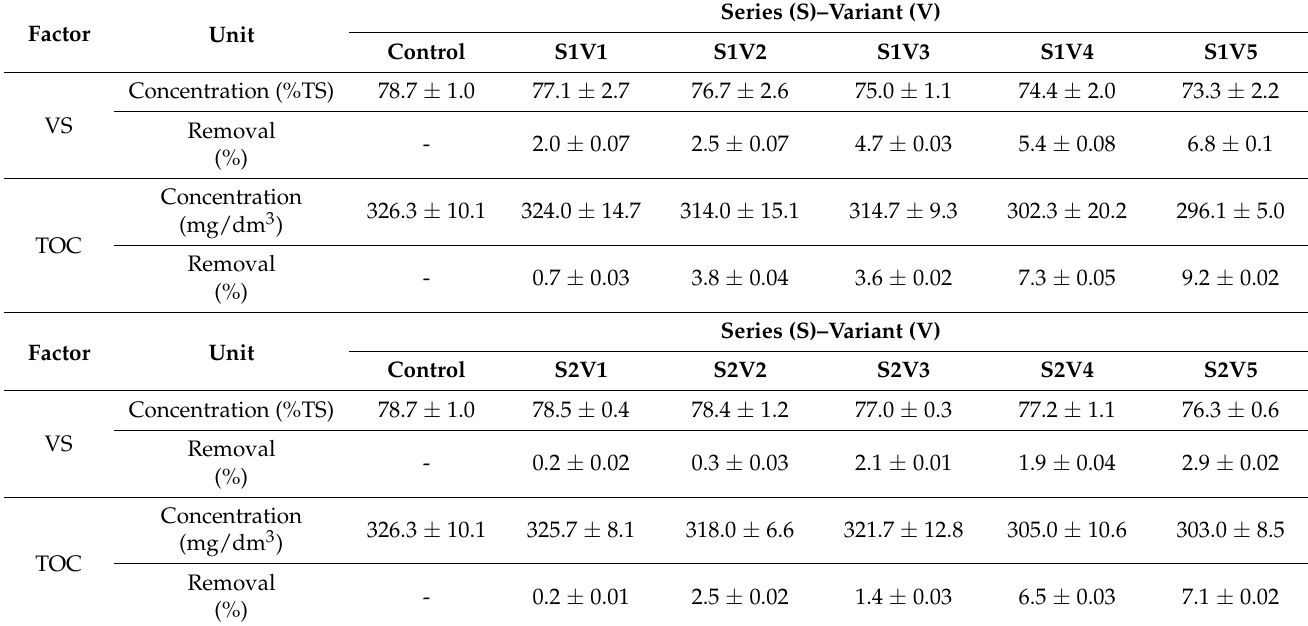
Table 3. Changes in concentrations of organic compounds (VS) and dissolved TOC in the PSS after